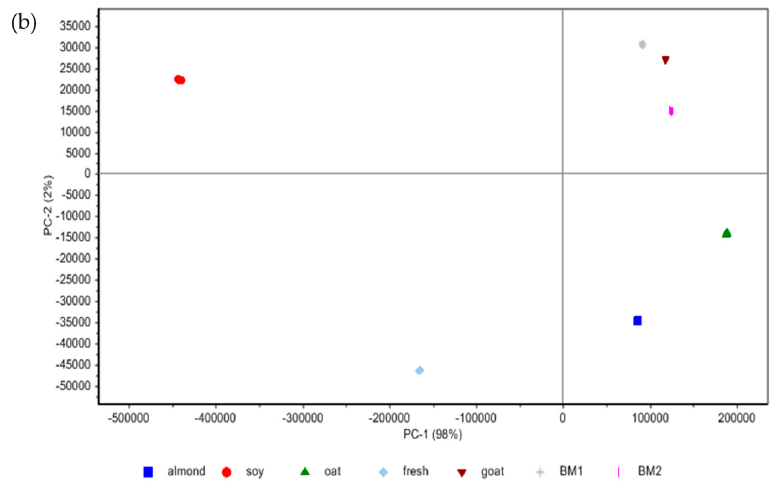
Figure 3. The principal component analysis (PCA) of absorbance spectra through ( a ) NIR spectrometer and ( b ) VIS-NIR spectrometer (BM is a short form for human breast milk).